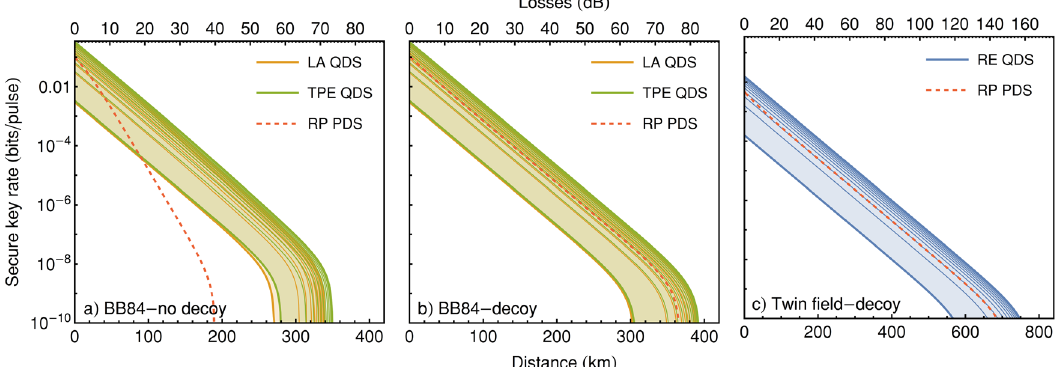
Fig. 2 Source comparison for three main QKD schemes. Simulated secret key rates using one-way classical post-processing 82,83 for ( a ) BB84 without decoy states, ( b ) BB84 with in fi nite decoy states, ( c ) twin- fi eld with in fi nite decoy states. The continuum in each plot shows the attainable key rates for QDS ranging from 1 to 100% collection ef fi ciencies, with intermediate curves showing steps of 10%. The dashed line indicates the optimal performance of randomized-phase (RP) PDS. For QDS, pulse lengths were chosen to simultaneously maximize the brightness and single-photon purities from Fig. 1: 3 ps for RE, 8 ps for LA, 12 ps for TPE. Chosen pulse areas: π RE for RE, 10 π RE for LA, π TPE for TPE. photon-number populations { p n } up to n = 3 were inferred from the subsequent values of brightness and single-photon purity. Parameters for all plots are: e = 2% single photon error rate, 0.21 dB/km single mode telecom fi ber losses, Y 0 = 10 − 9 dark count probability, unit detection ef fi ciency, and error-correcting code inef fi ciency f =